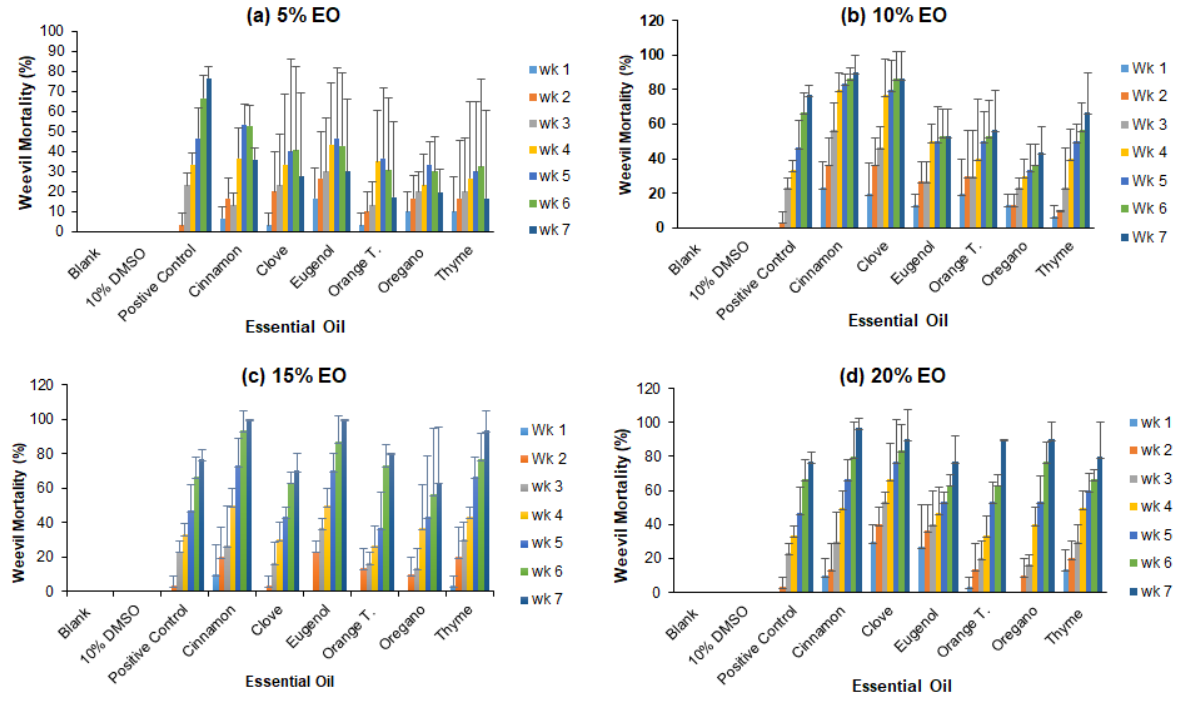
Figure 3. The mortality of maize weevils during storage in the presence of different essential